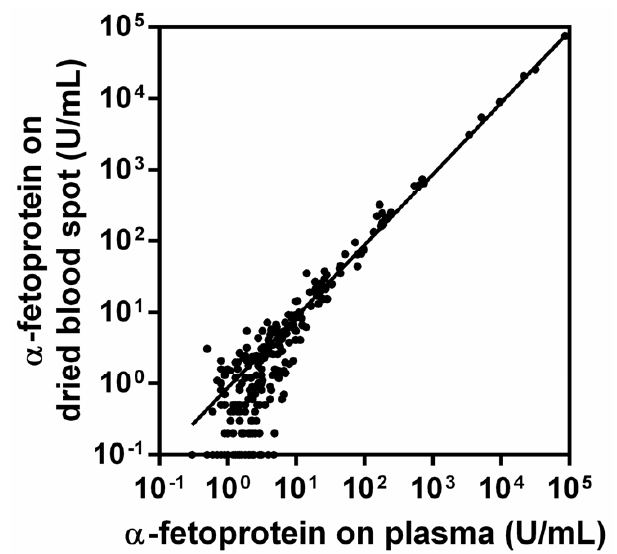
Figure 1. Correlation between α -fetoprotein ( α PF) measured on plasma and on dried blood spot (DBS) ( r 2 = 0.999, p < 0.001).